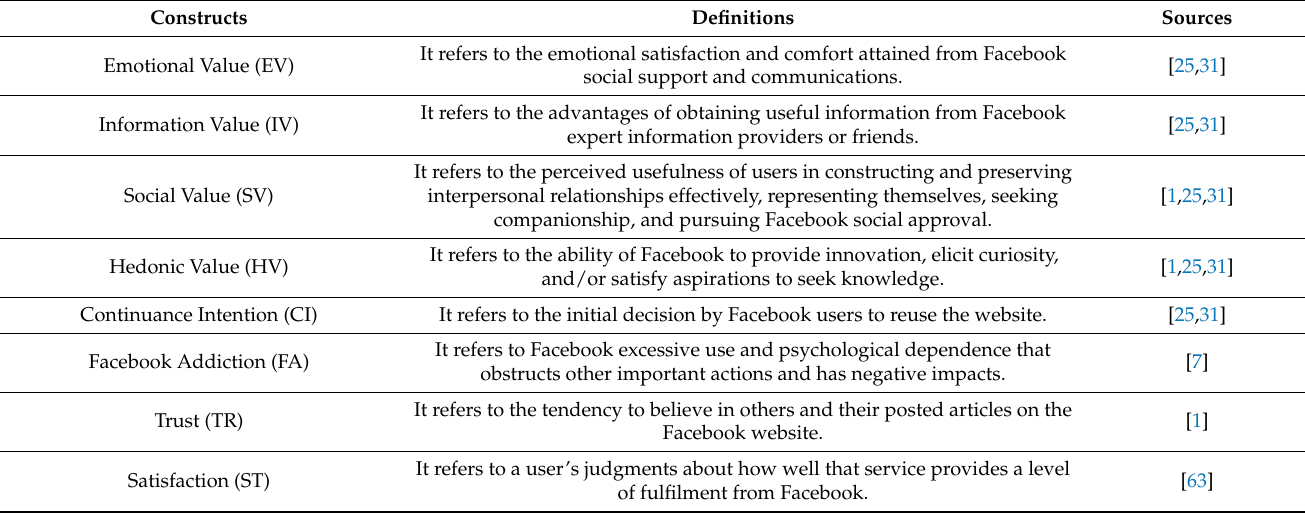
Table 2. Definitions of variables.